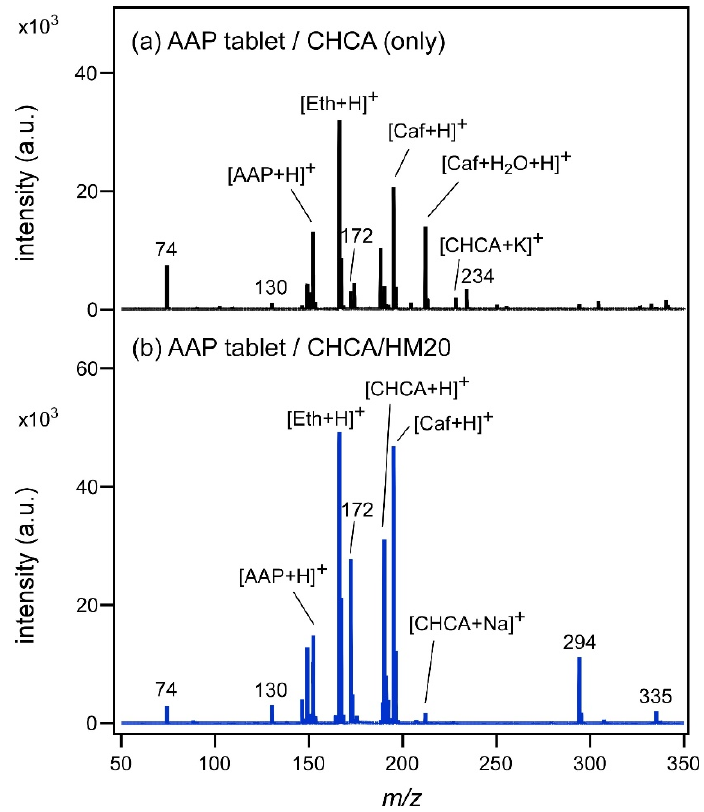
Figure 1. ( a ) MALDI mass spectrum of AAP tablet measured with CHCA as matrix. ( b ) SALDI mass spectrum of AAP tablet measured with CHCA/HM20.